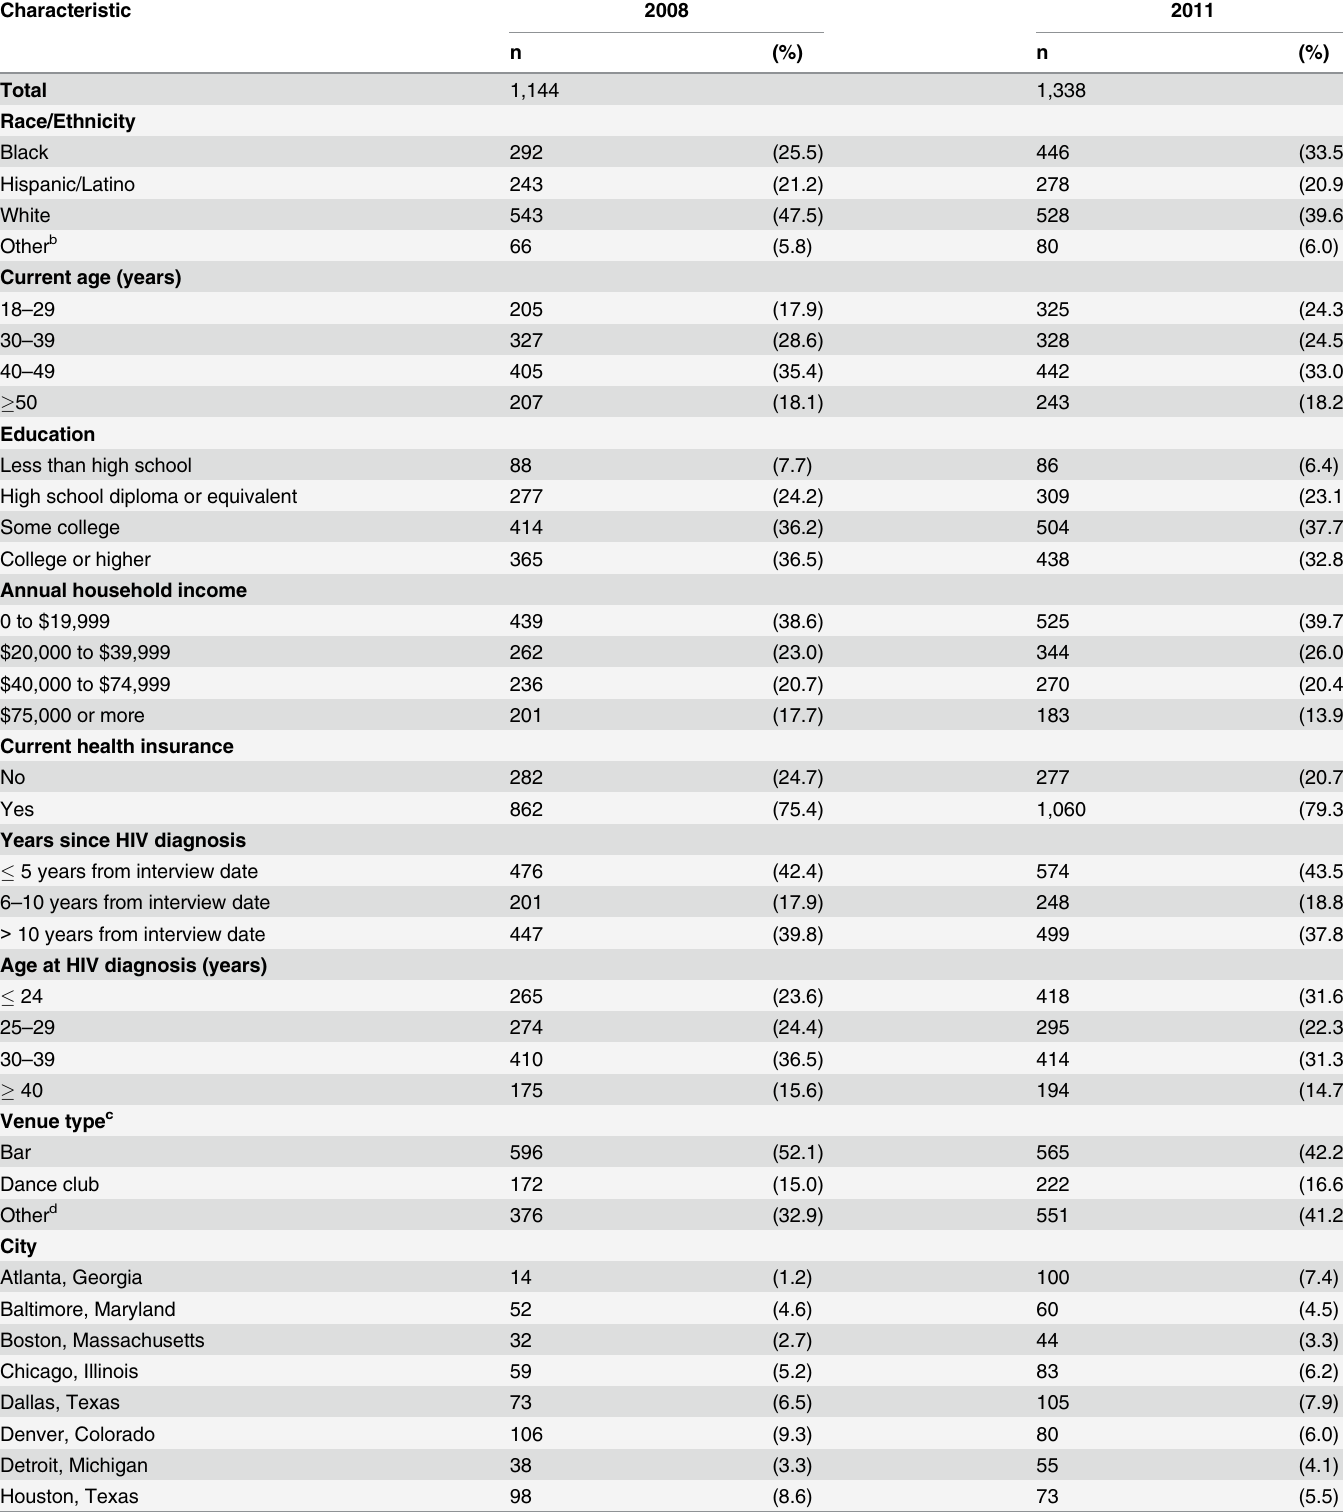
Table 2. Characteristics of HIV-positive men who have sex with men – NHBS, 2008 and 2011.